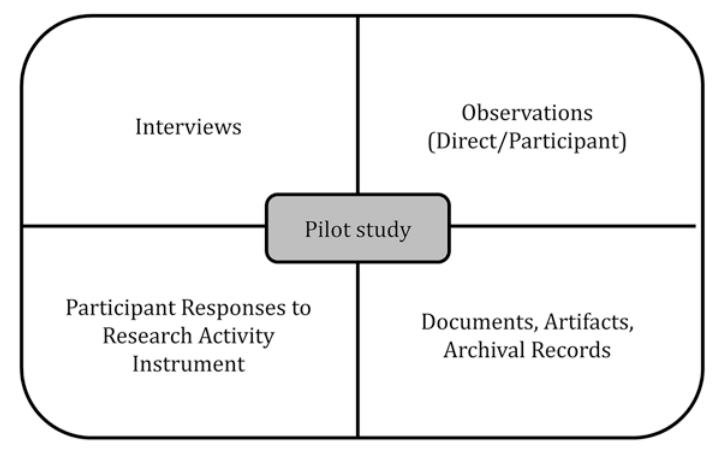
Figure 1 Key sources of data for a sample case